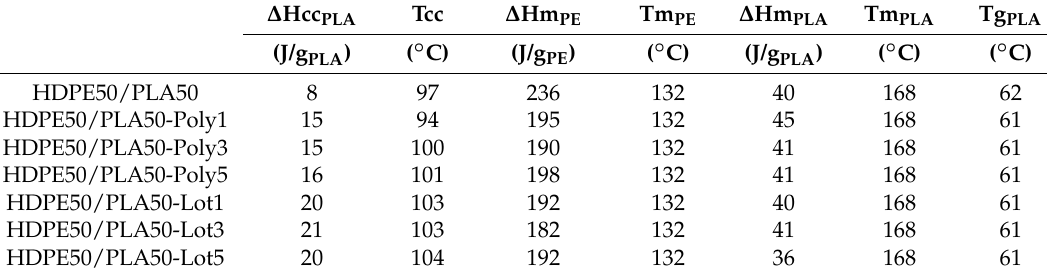
Table 5. DSC results of HDPE50/PLA50 with 1, 3, 5 wt.% of Lotader AX8840 and Polybond 3029. ∆ Hcc